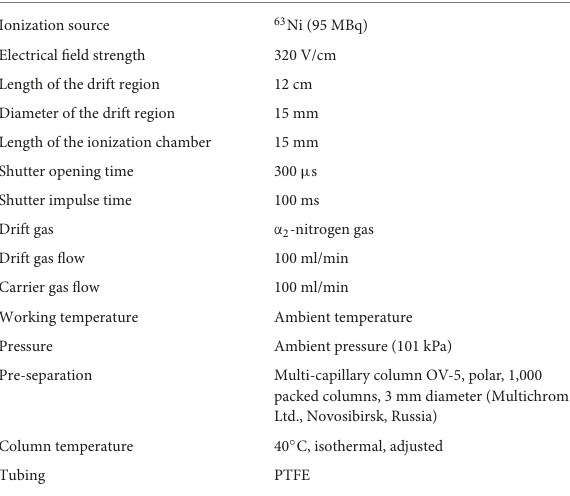
TABLE 1 Multicapillary column/ion mobility spectrometry (MCC-IMS)